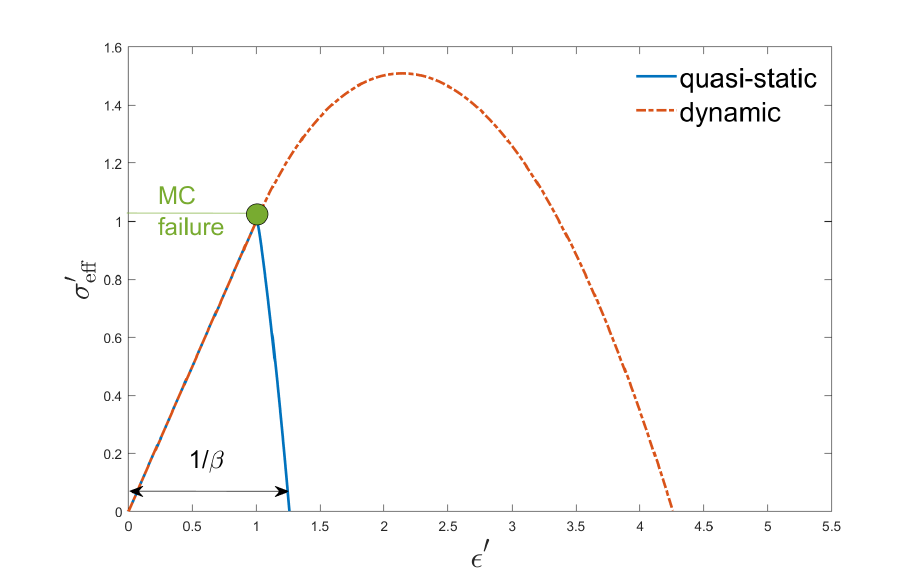
Figure 4. Sample quasi-static and dynamic strain versus stress